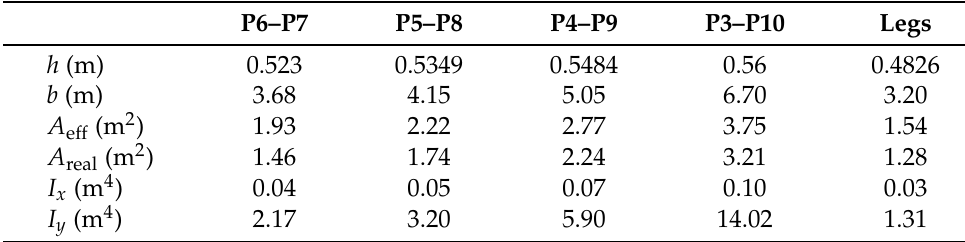
Table 3. Equivalent rectangular cross-sections of the concrete deck [36].